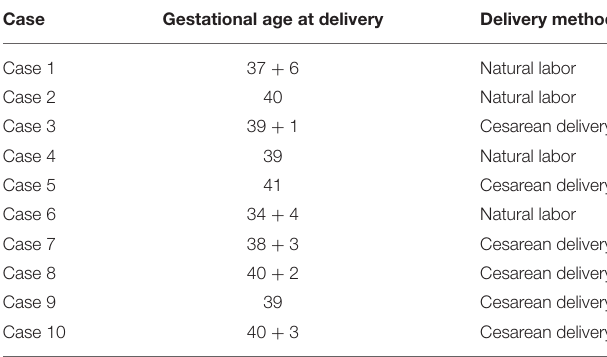
TABLE 3 | Obstetric outcome of the